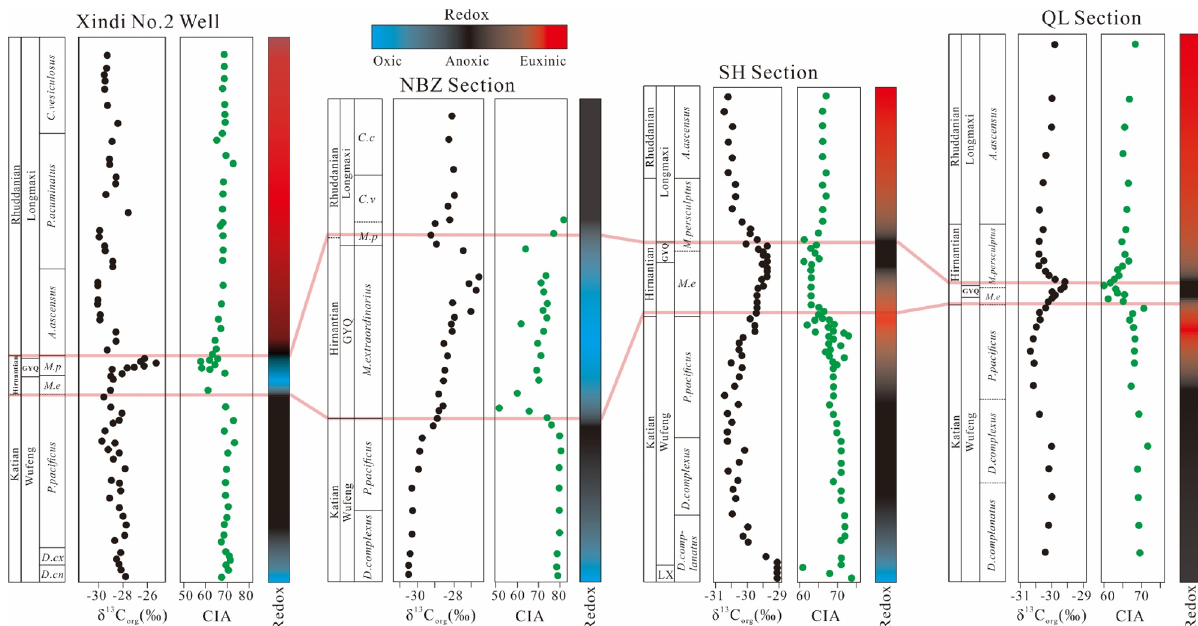
Figure 15. General trends of δ 13 C org , climate change, and redox conditions in the Xindi No. 2 well (this study), NBZ 42 , SH, and QL 20 sections. Graptolite zones: D. cn.—Dicellograptus complanatus; D.